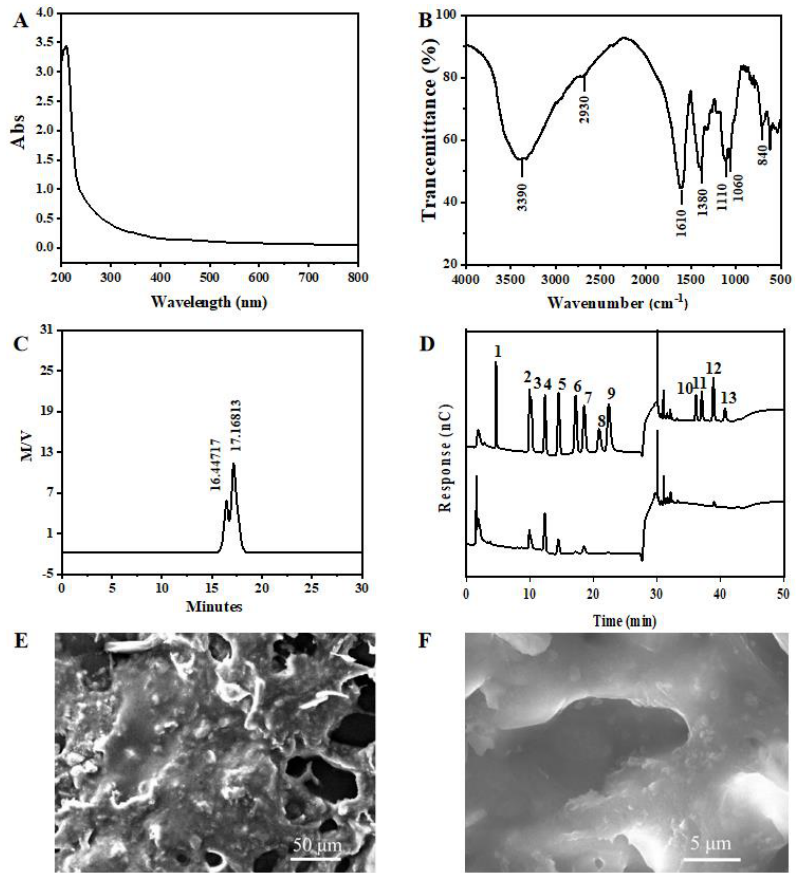
Figure 2. Structural characterization of grape pomace polysaccharides (GPPs). ( A ) UV spectrum of GPPs. ( B ) FT-IR spectrum of GPPs. ( C ) Molecular weight of GPPs. ( D ) Monosaccharide composition of GPPs; the standards from 1 to 13 were Fuc, Ara, Rha, Gal, Glc, Xyl, Man, Fru, Rib, GalA, GulA, GlcA and ManA, respectively. SEM images of grape pomace polysaccharides at ( E ) 400 × and ( F ) 5000 × ,